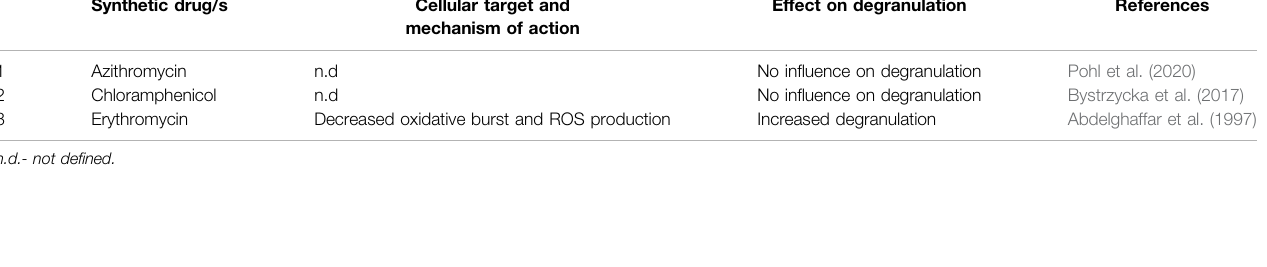
TABLE 6 | List of selected synthetic drugs with documented impact on degranulation of neutrophils. Synthetic drug/s